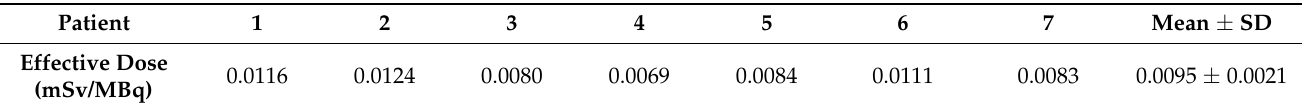
Table 3. Effective dose (mSv/MBq) for [ 64 Cu]Cu-SAR-BBN. Mean and standard deviation (SD) are shown across all subjects.